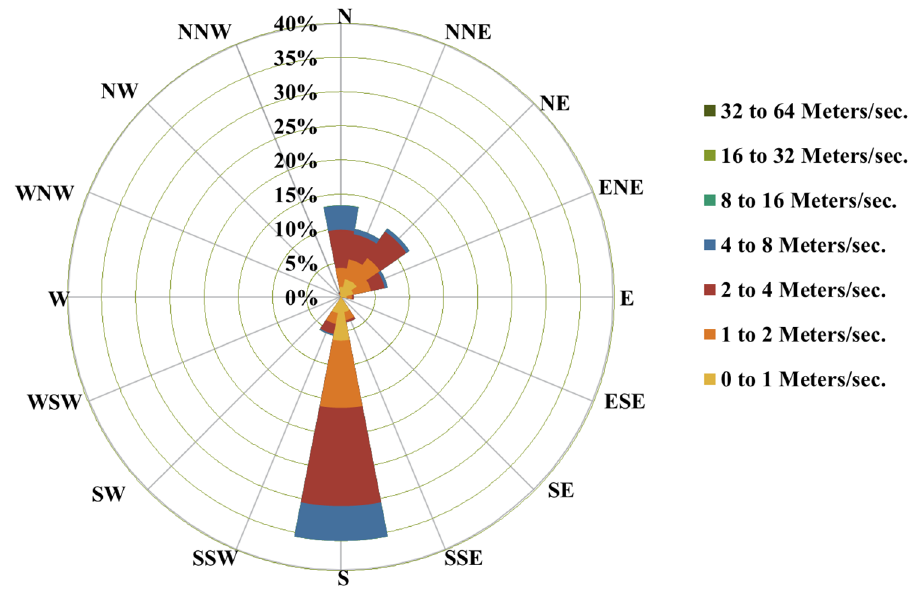
Figure 4. DS Mine wind rose, October 2012–December